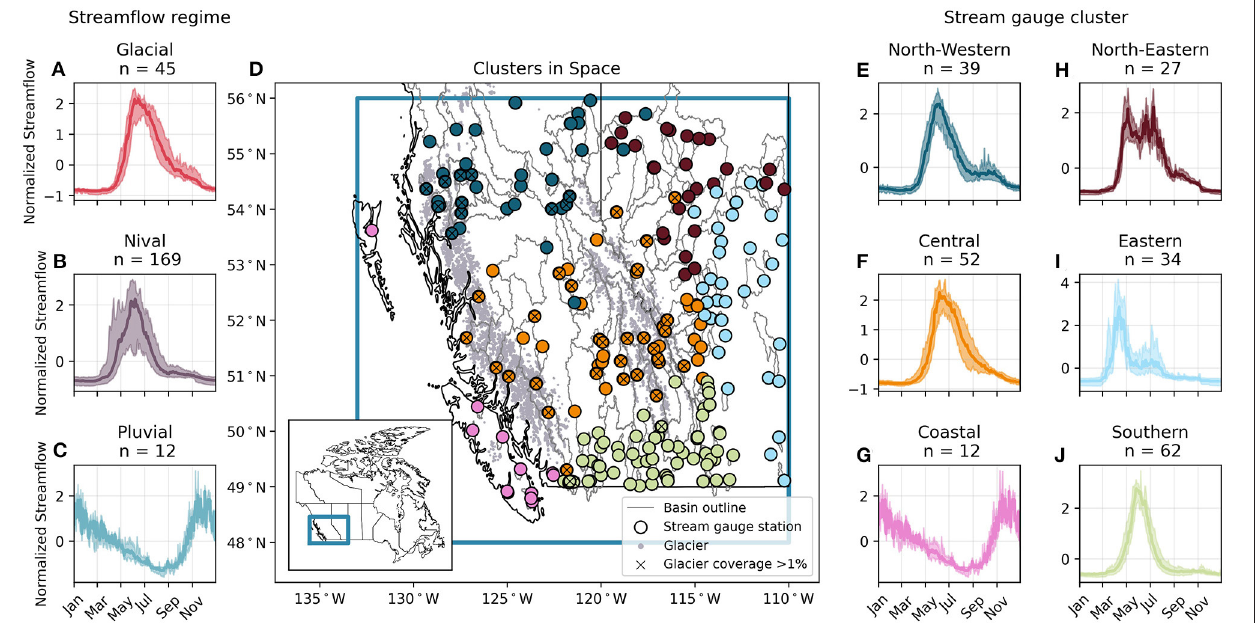
FIGURE 1 | Map of the study region, and hydrographs of streamflow regimes and sub-regional clusters. (A–C) The mean seasonal streamflow patterns of each streamflow regime (solid line), with one standard deviation range (shaded area) derived from all stream gauge stations in the given regime. (D) The basin outlines, and stream gauge locations that are colored according to the geographically constrained seasonal streamflow clusters. Gray dots show the locations of glaciers taken from RGI V6.0. (E–J) The mean seasonal streamflow patterns of each geographically constrained cluster of stream gauges (solid line), with one standard deviation range (shaded area) derived from all stream gauge stations in the given cluster. Note that all stations of the glacial regime (i.e., with > 1% glacier coverage) are marked with an “x.” The nival regime is made up of all stations with < 1% glacier coverage located in the north-western, central, southern, eastern, and north-eastern clusters. The pluvial regime includes all stations from the coastal